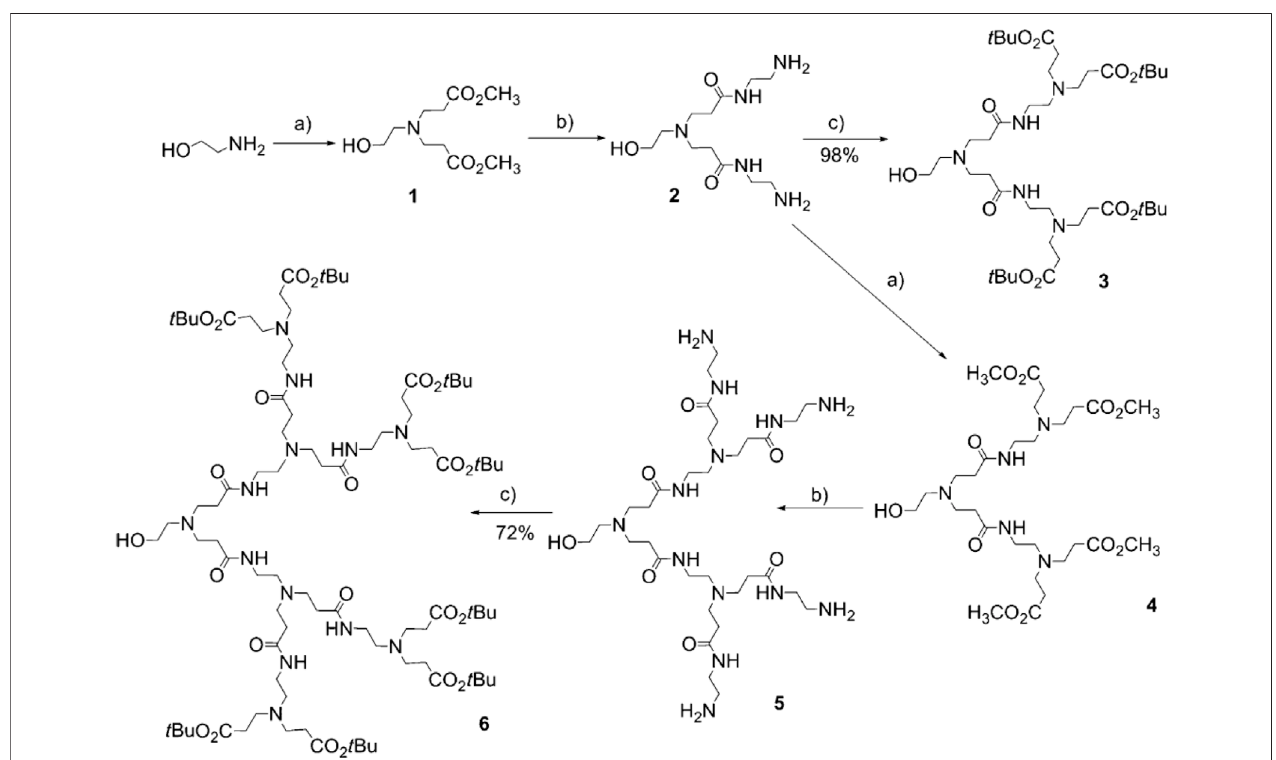
FIGURE 2 | Condensation polymerization of AB 2 -type monomers into hyperbranched polymers (Rousseau et al., 2013).